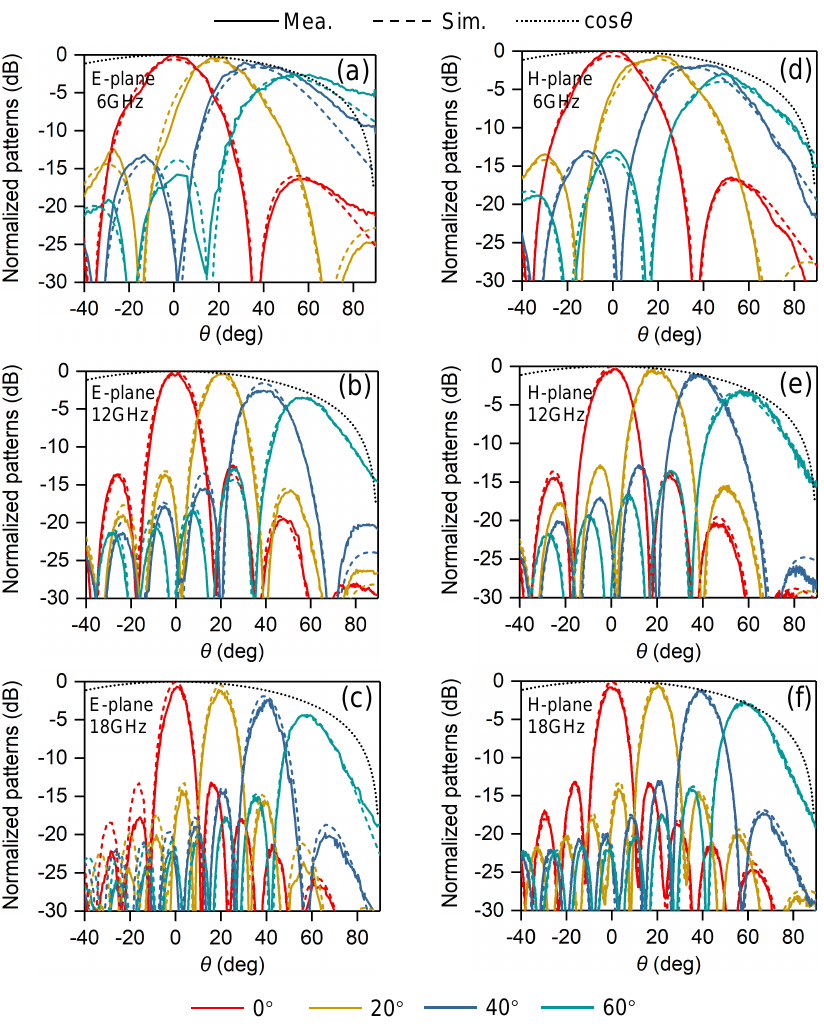
Figure 17. Measured and simulated normalized radiation patterns for 0 ◦ , 20 ◦ , 40 ◦ , and 60 ◦ scans in the principal planes. ( a ) E-plane @ 6 GHz; ( b ) E-plane @ 12 GHz; ( c ) E-plane @ 18 GHz; ( d ) H-plane @ 6 GHz; ( e ) H-plane @ 12 GHz; ( f ) H-plane @ 18